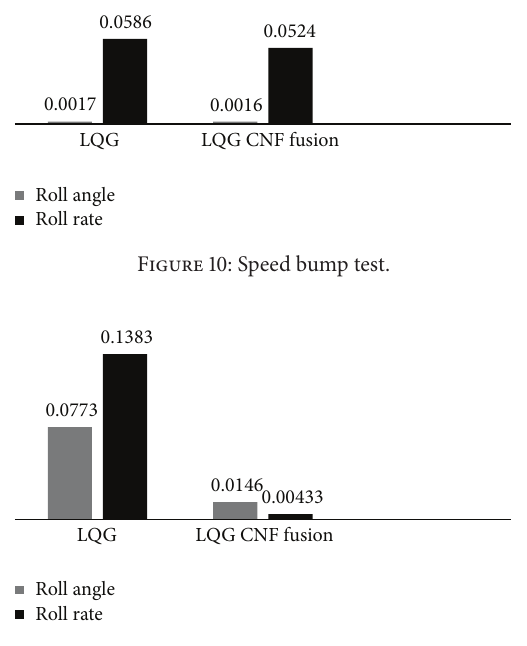
Figure 11: Fishhook test.